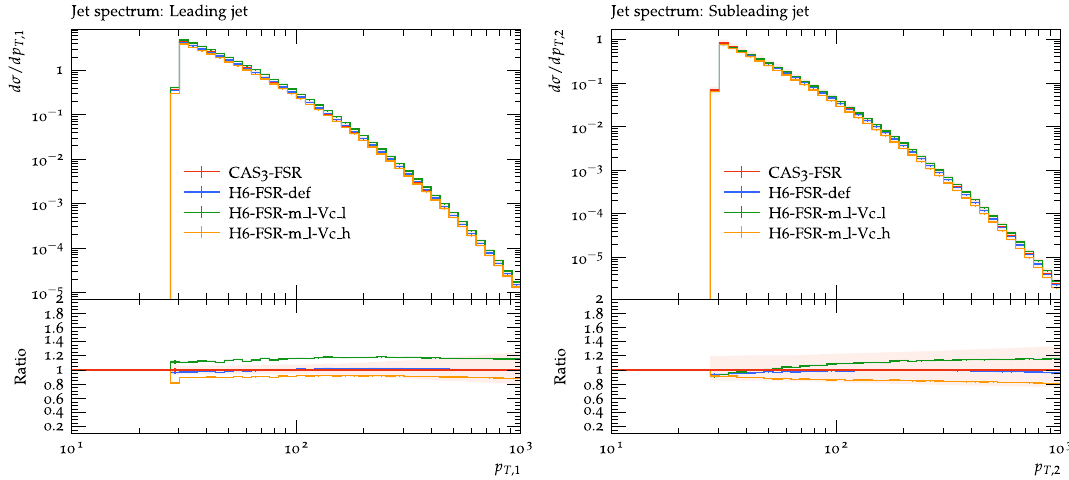
Fig. 7 Comparison of predictions obtained with MCatNLO+CAS3 and MCatNLO+H6 for Z + jet obtained with MCatNLO. Shown are predictions using only final state parton shower. The band of MCatNLO+CAS3 shows the uncertainties obtained from scale variation (as described in the